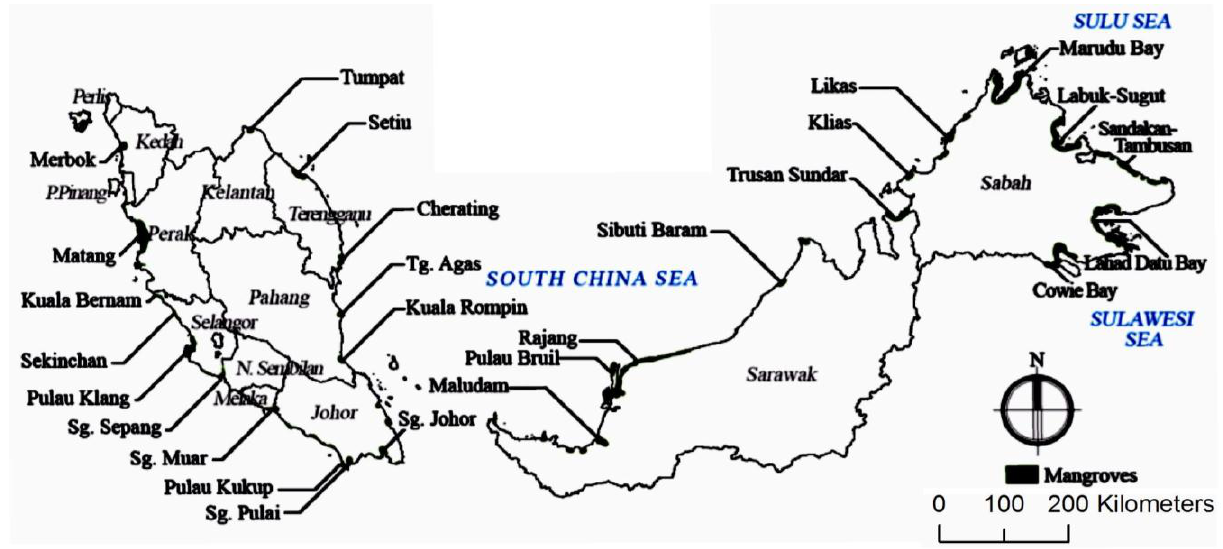
Figure 1. Mangrove forests distribution in Malaysia (Upper left: 7°22′46″N, 98°55′48″E and Lower right: 0°51′10″N, 119°16′00″E)